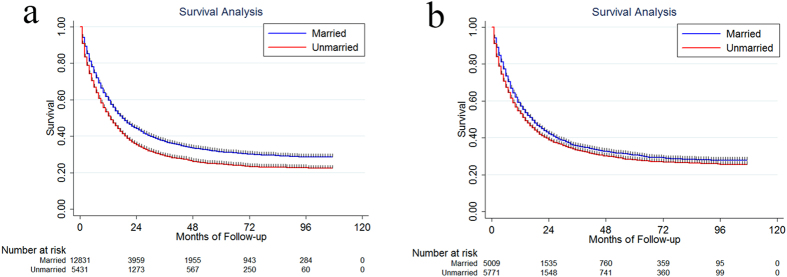
The survival difference between married and unmarried patients in male (a) and female (b).